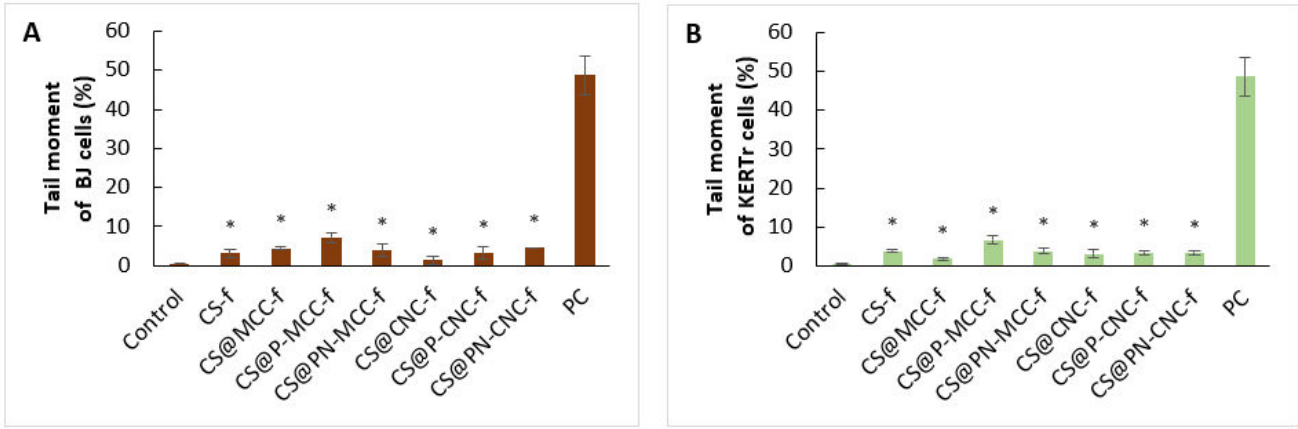
Figure 8. The genotoxicity of BJ ( A ), KERTr ( B ) cells incubated for 24 h with chitosan-cellulose biocomposites, n = 6, * p <